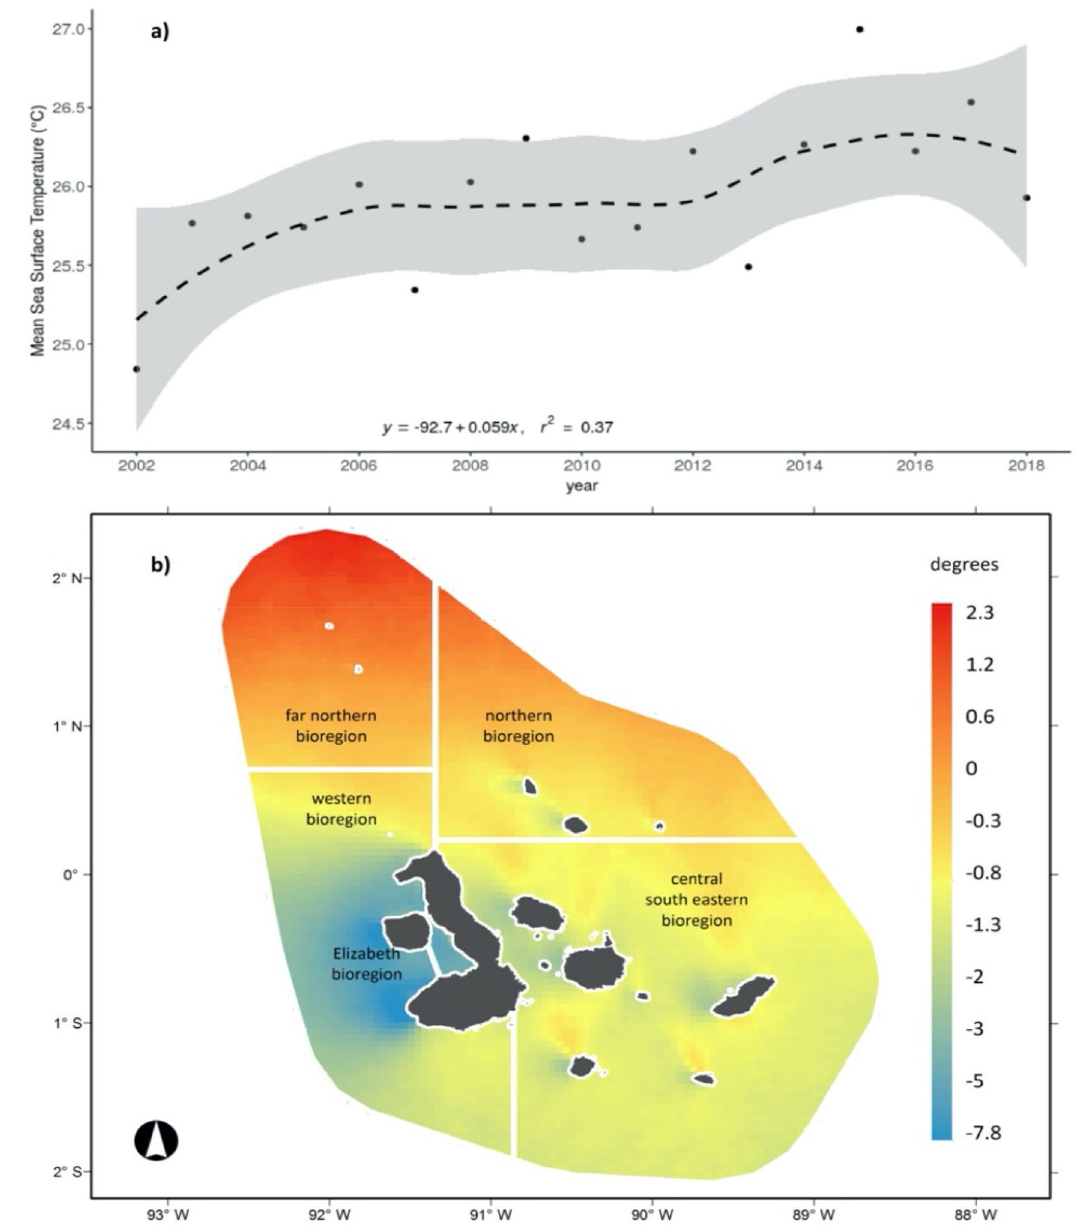
Figure 5. ( a ) Mean Sea Surface Temperature (SST) in the Galapagos Marine Reserve (GMR) derived from the SST MODIS L3 product for 2002–2018. Line represents the fitted linear regression between observed mean SST in the GMR for each year. The shaded area represents the 95% confidence interval ( b ) mean annual anomalies of Sea Surface Temperature (SST) in degrees for the period 2002–2018. White lines represent the five marine bioregions of the GMR as defined by Edgar et al. 26